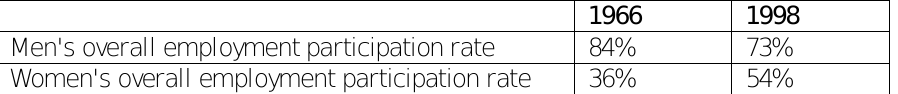
Table 1: Employment participation rates of men and women in Australia